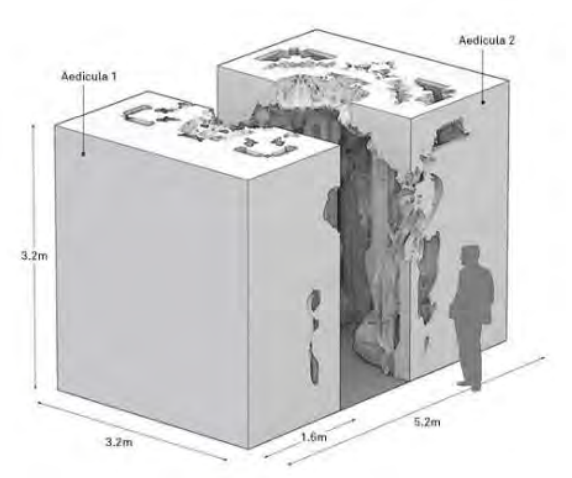
Figure 8. Isometric view to the whole mass.